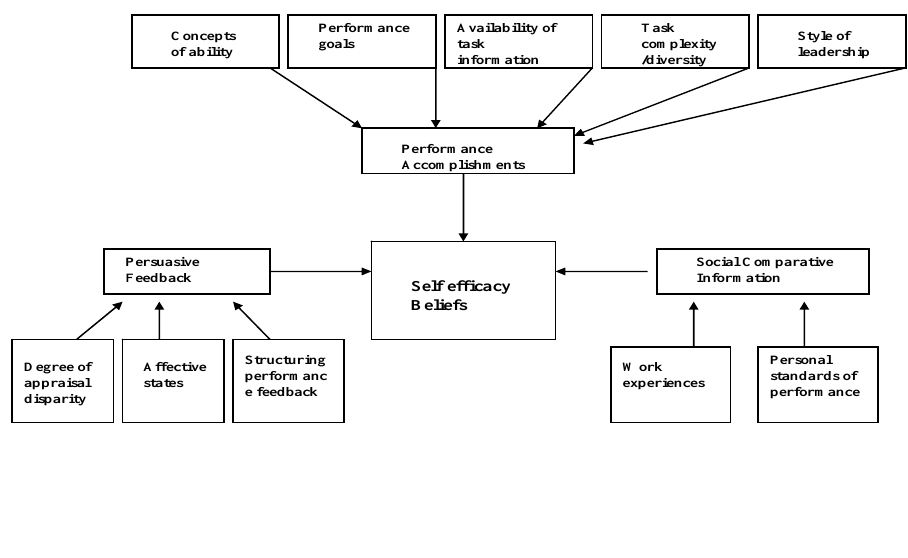
Figure 1: Model of information referents in work environment that contribute to the development of self efficacy